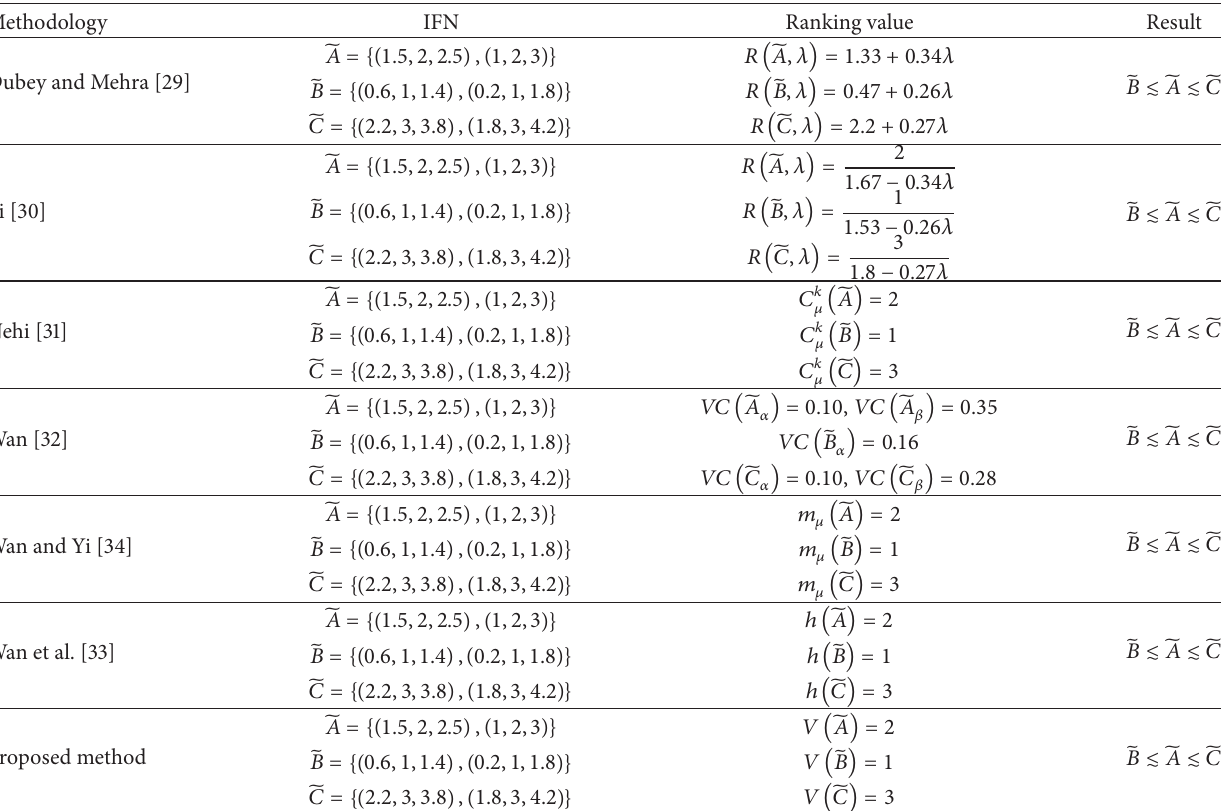
Table 1: Comparison between ranking